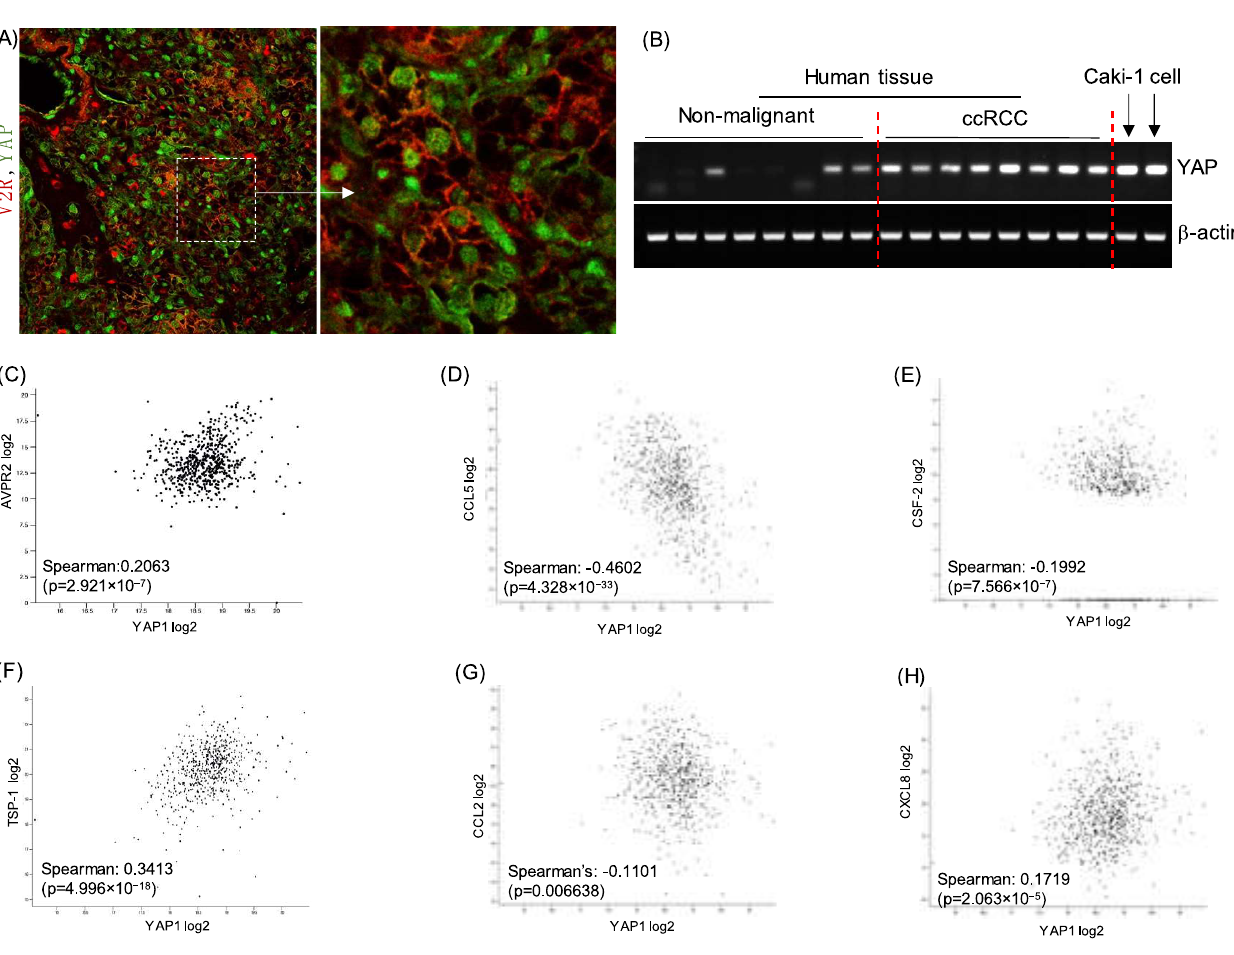
Figure 3. YAP expression in ccRCC tumor cells and correlation with V2R regulated secreted factors: ( A ) Immunostaining for V2R (red) and YAP (green) in human ccRCC tumor tissue, ( B ) YAP mRNA levels in human ccRCC tumor and non-malignant kidney tissue. ( C ) Correlation plot using GDC TCGA Kidney Clear Cell Carcinoma (KIRC) Cohort ( n = 985) for YAP1 vs. V2R (AVPR2 gene), ( D ) YAP1 vs. CCL5, ( E ) YAP1 vs. CSF2, ( F ) YAP1 vs. TSP1, ( G ) YAP1 vs. CCL2, ( H ) YAP1 vs. CXCL8. Gene expression RNAseq-HTSeq-FPKM-UQ Unit: log2 (fpkm-uq + 1) shown in C to